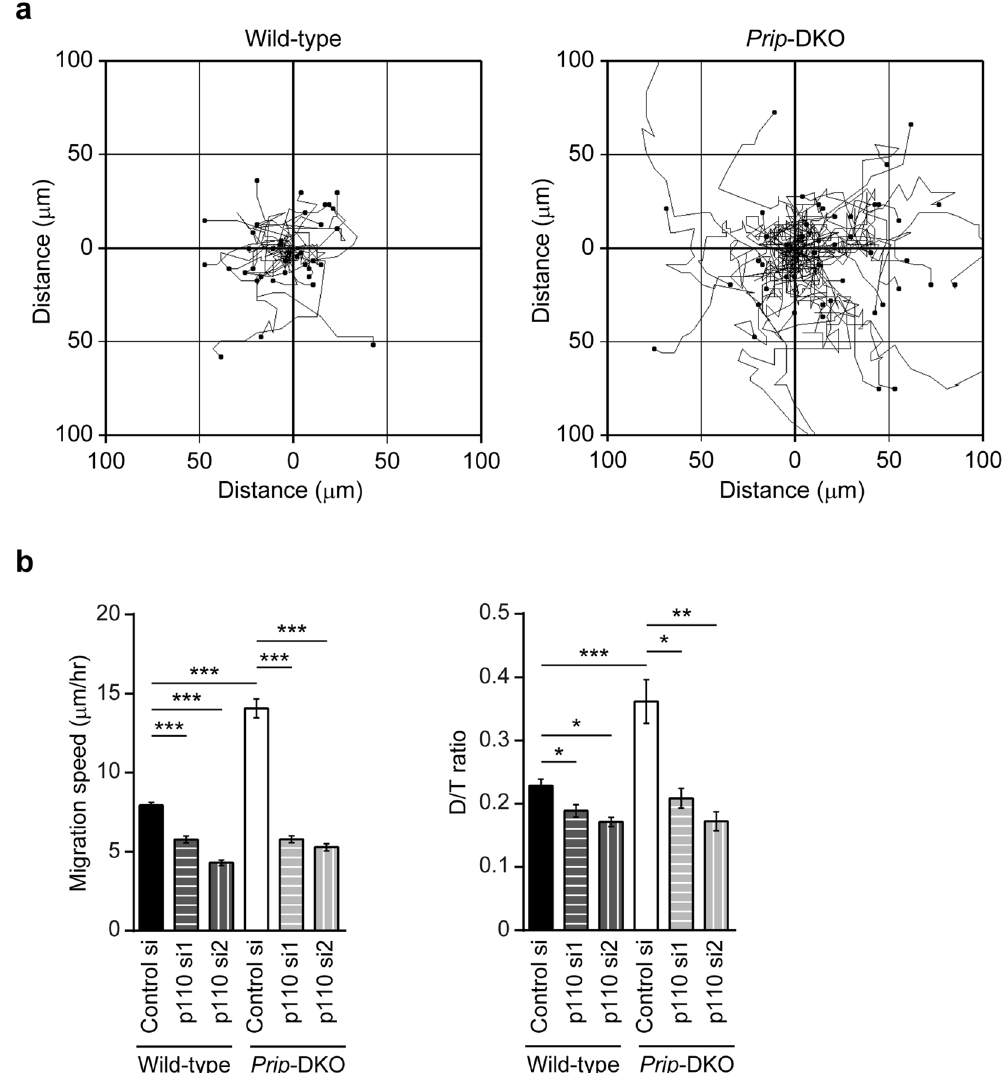
Figure 2. PRIP participates in PI3K-mediated cell migration. ( a , b ) Chemokinesis assay. Random migration of MEFs was monitored by microscopy after stimulation with 20 ng/mL PDGF ( a ). Representative track plots from at least three independent experiments are shown. Mouse Pik3ca -siRNAs (p110 si1 and p110 si2) and control siRNA (control si) were used for the experiments ( b ). Bar graphs show comparisons of migration speed and D/T ratio. Chemokinesis assays were performed at least three times for each indicated experiment. Data are presented as means ± SEM. The number of samples of control si, p110 si1, and p110 si2 is n = 25, 25, and 25 in wild-type, and n = 25, 23, and 21 in Prip -DKO, respectively. * p < 0.05, ** p < 0.01, *** p < 0.001 between the indicated bars (Kruskal–Wallis test followed by Dunn’s multiple comparison